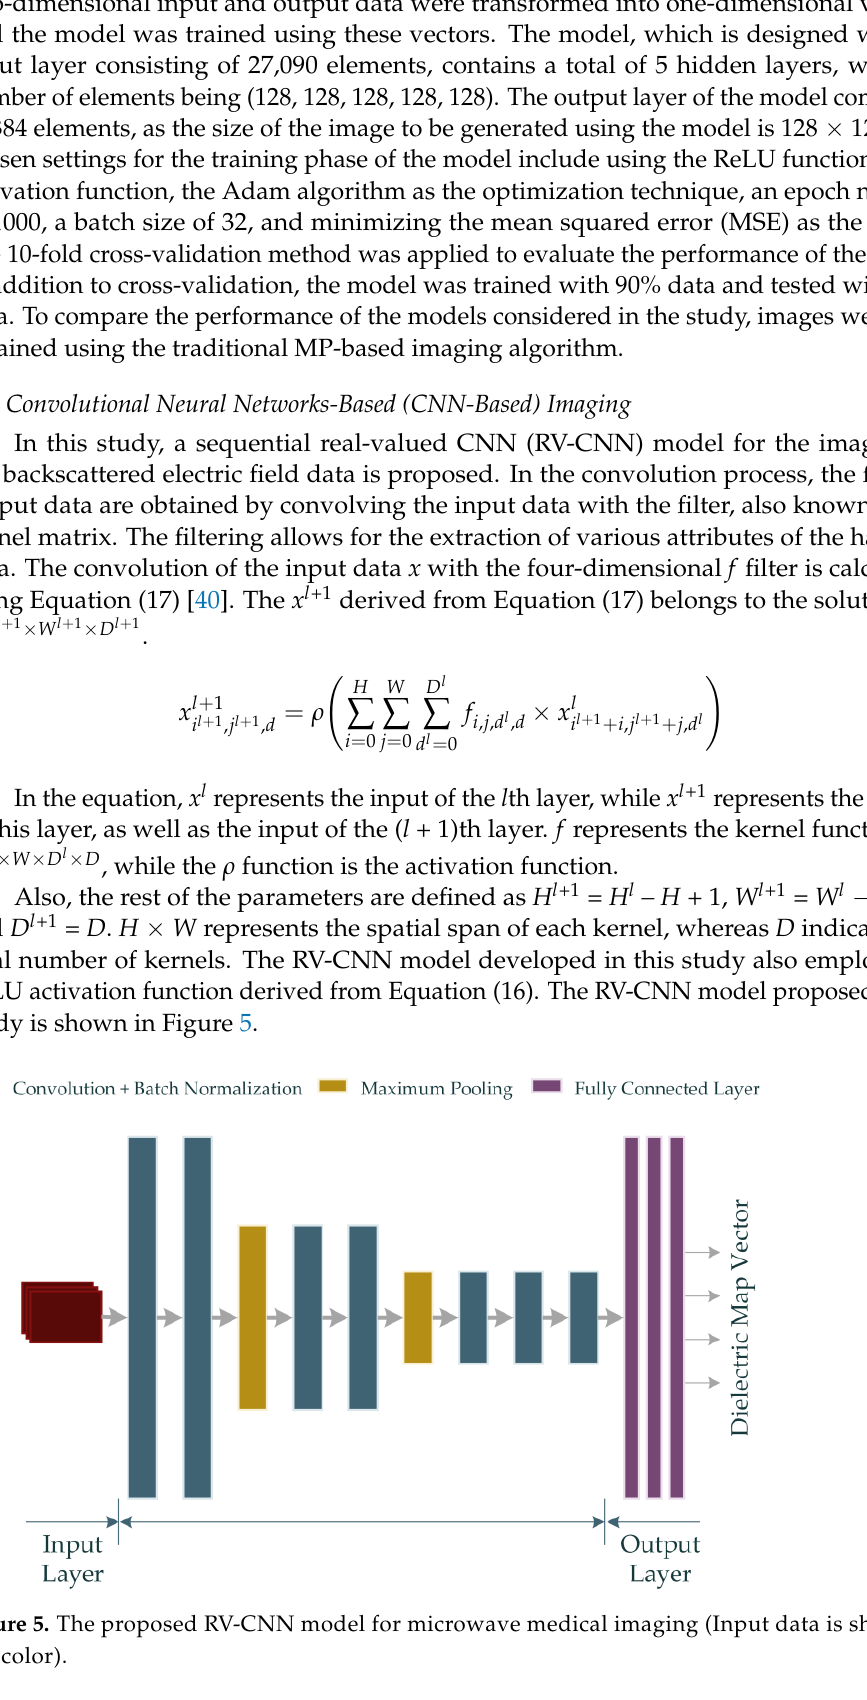
Table 2. Properties of the proposed CNN-based model layers.